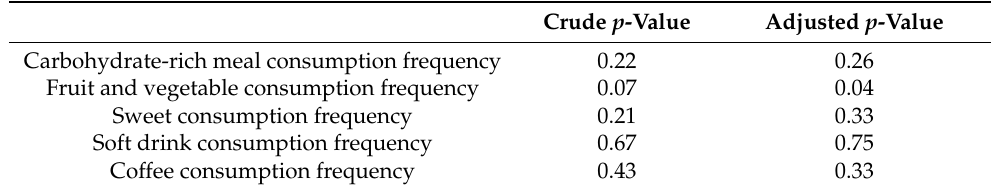
Table 2. Crude and adjusted 1 results from the analysis of associations of semi-quantitative food frequency data with